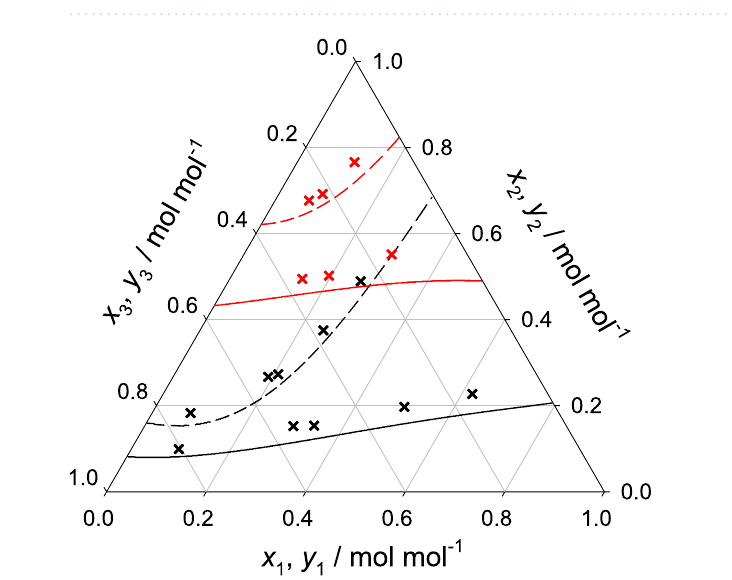
Figure 2. Vapor-liquid equilibria of the six binary subsystems at 298.15 K. Simulation-based Wilson predictions (lines) are compared with experimental literature data 30–38 (crosses).